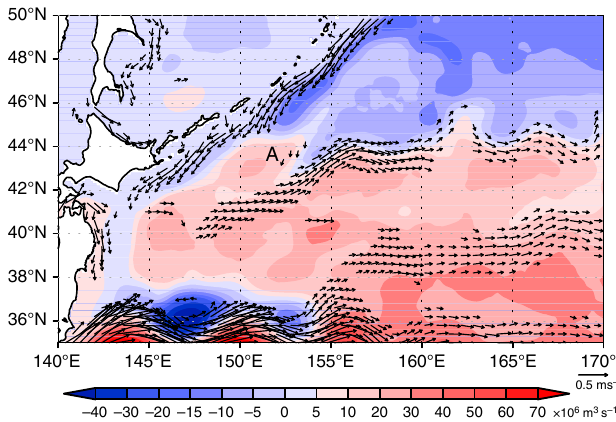
Fig. 7 Barotropic streamfunction and a jet formation in a western North Paci fi c simulation. Temporal mean fi eld of barotropic streamfunction (color shade; ×10 6 m 3 s − 1 ) and surface current at a depth of 12 m (vector, cm s − 1 ) of the Meteorological Research Institute Community Ocean Model (MRI. COM) 32,33 are indicated. The simulation exhibits anticyclonic barotropic fl ow over the rise A and the Isoguchi J1. Model con fi gurations are described